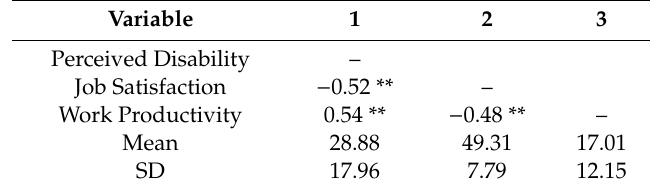
Tabled values are zero-order correlations. * p < 0.05; ** p < 0.01.